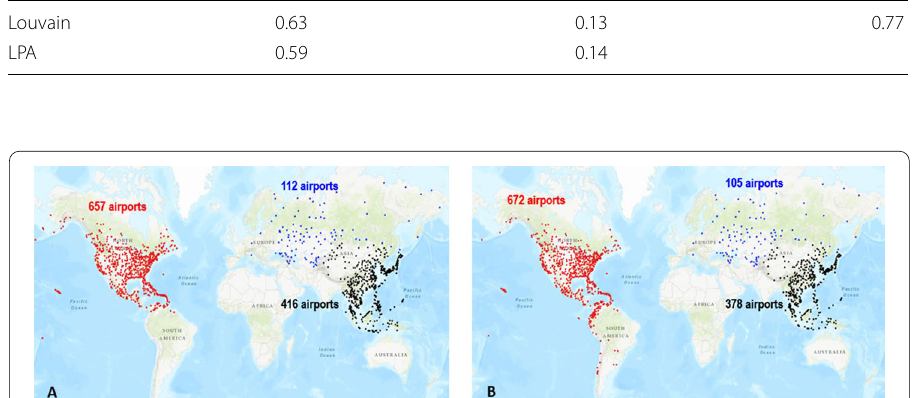
Fig. 2 The community detection algorithms uncover similar communities. a Louvain reveals 3 communities in North and Central America-Caribbean (airports in red), East-Southeast Asia (airport in black), and in Russia-Central Asia-Transcaucasia (airports in blue). b LPA finds similar communities in these